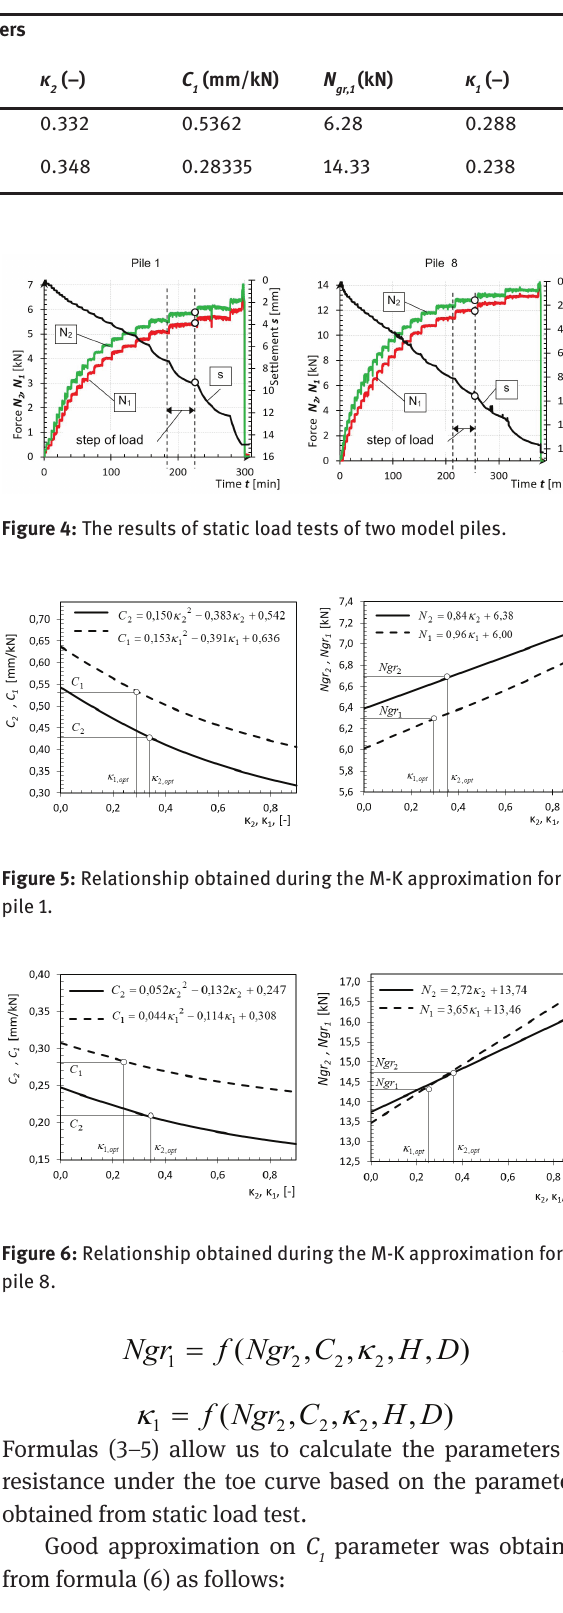
Fig. 4. The results of static load tests of two model piles.